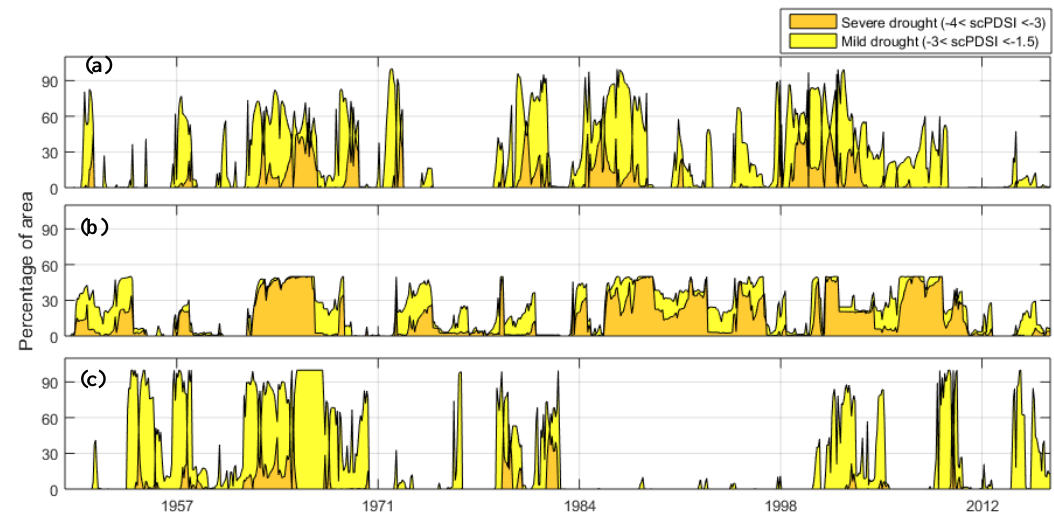
Figure 9. Time series of drought affected area in percentage for all three study areas calculated on the basis of percentage of grid cells facing drought with scPDSI ≤ −1.5 (mild drought) and scPDSI ≤ 3 (severe drought). ( a ) Araveli Region, ( b ) Bundelkhand Region, ( c ) Kansabati River Basin.